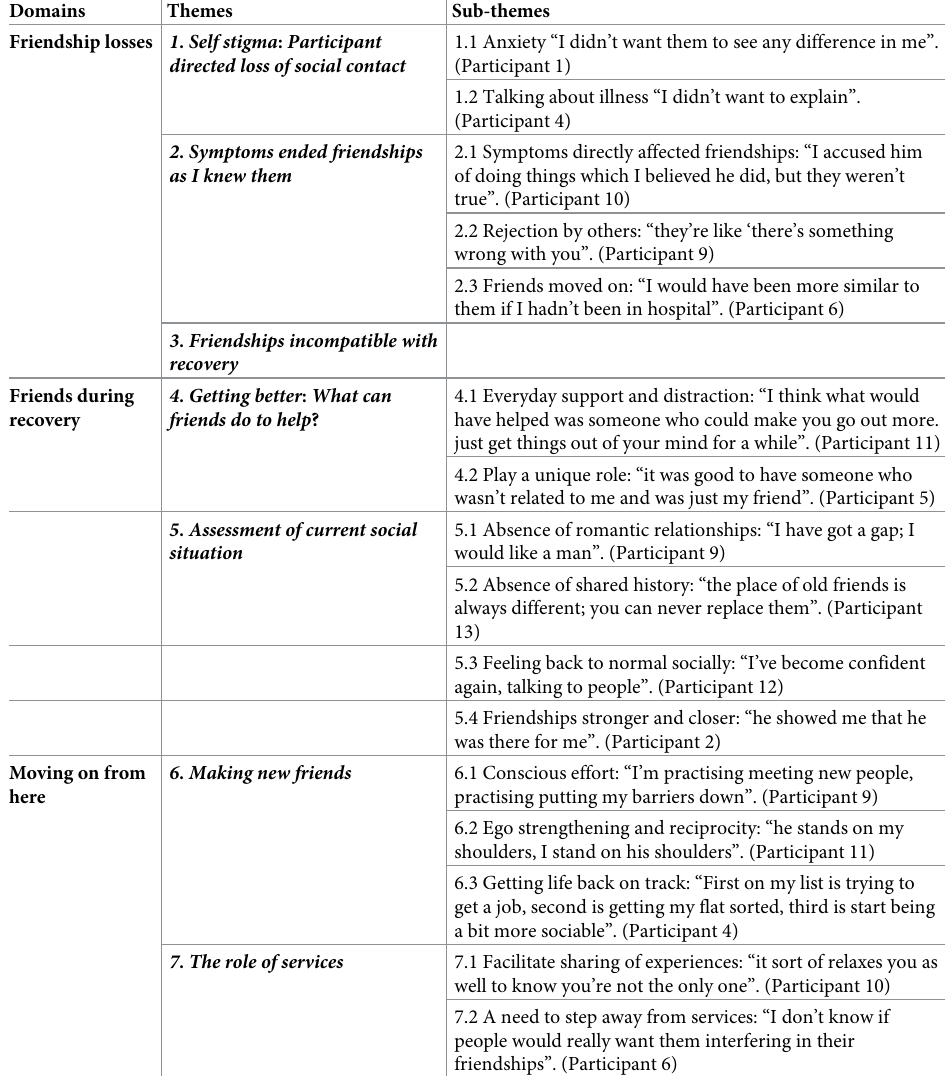
Table 2. Overview of themes and